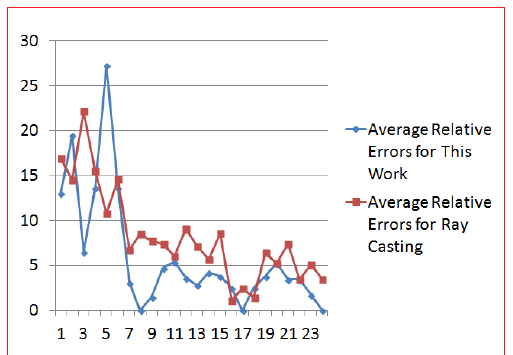
Figure 28. Ray casting’s interpolation error verses this work’s interpolation error. The horizontal axis refers to samples (multiples of hundred) and the vertical axis refers to average relative errors.